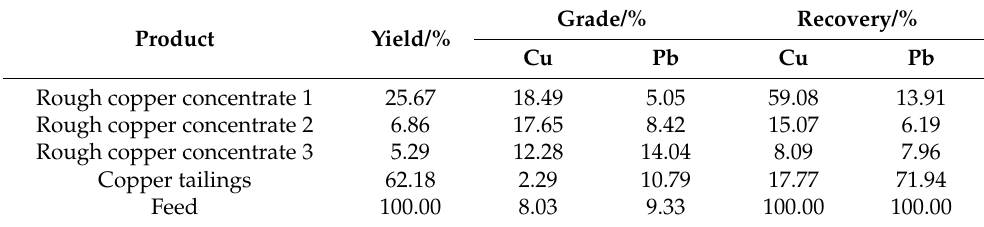
Table 2. Flash flotation time of the copper